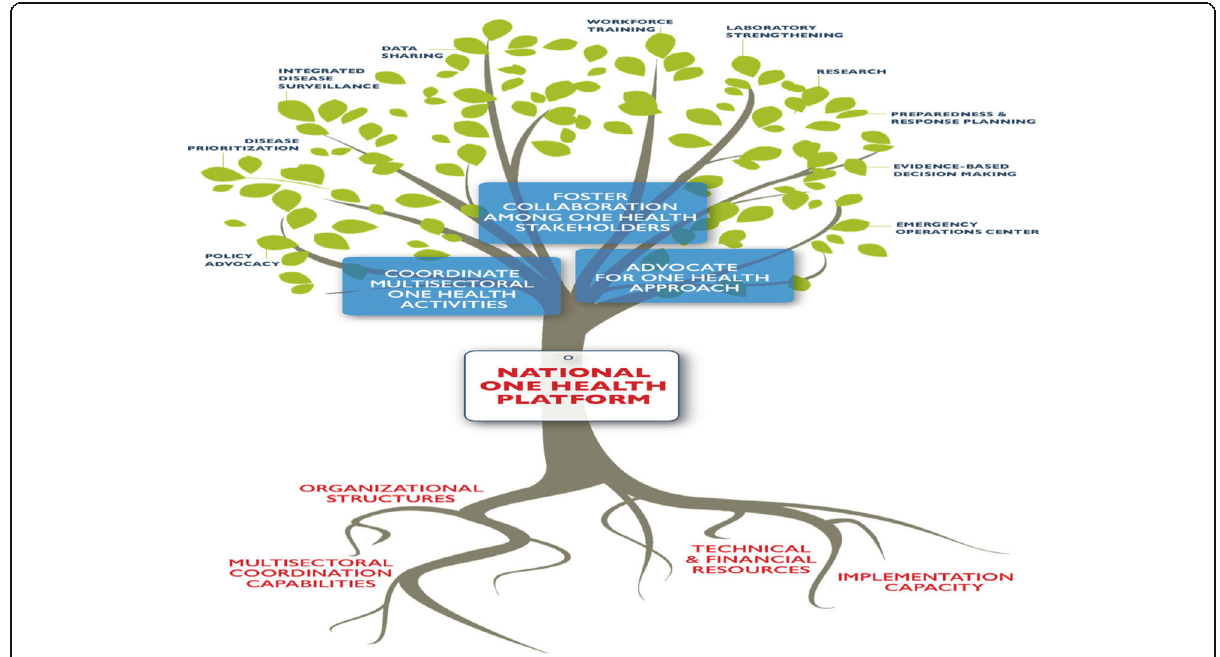
Fig. 1 The Structure and Responsibilities of the National One Health